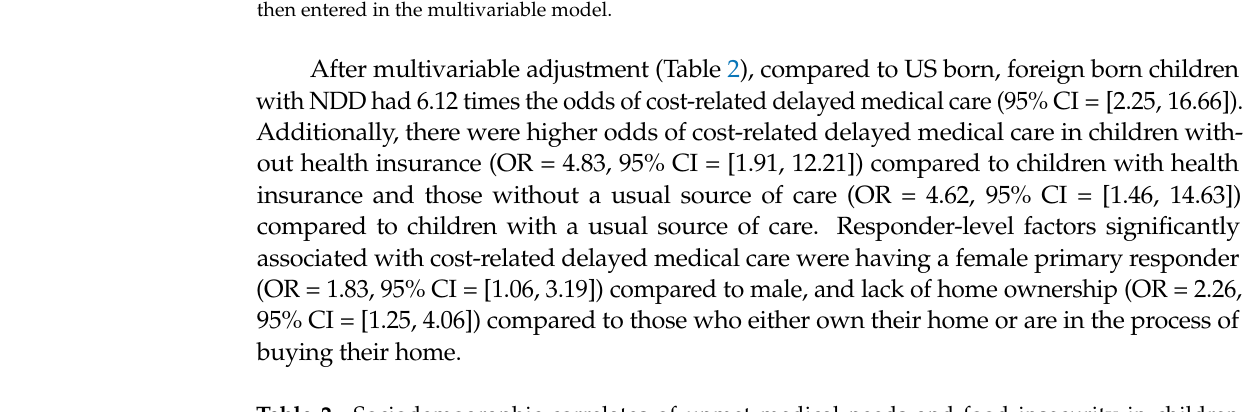
Table 2. Sociodemographic correlates of unmet medical needs and food insecurity in children with